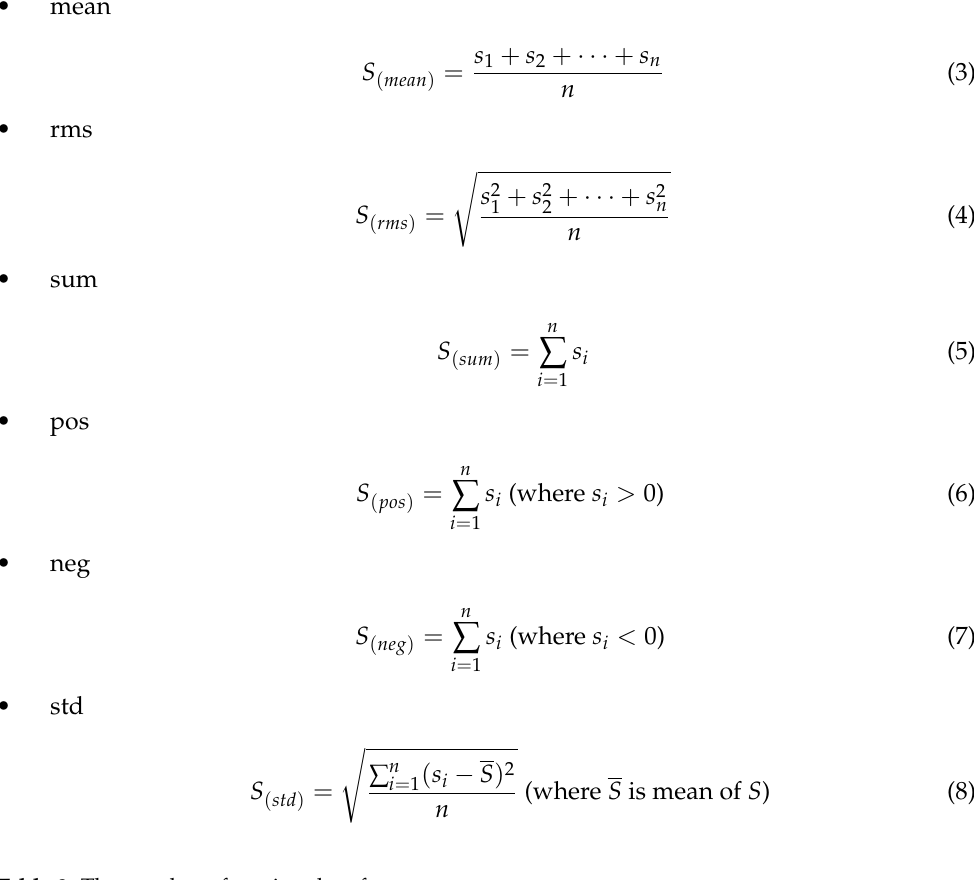
Table 3. The number of motion data